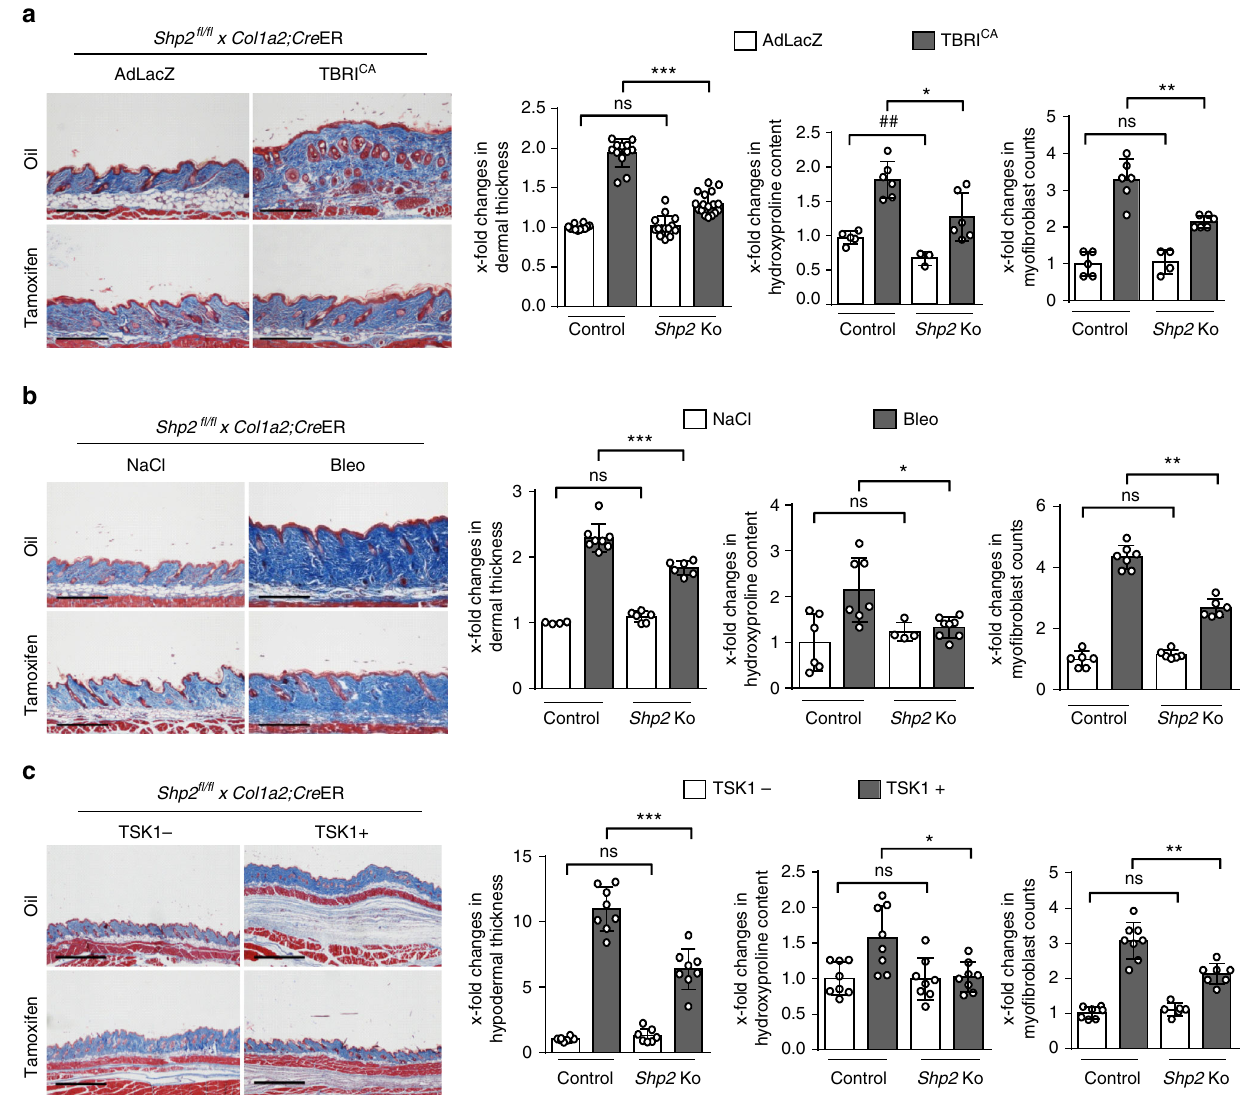
Fig. 4 Fibroblast-speci fi c knockout of Shp2 protects from experimental fi brosis. a TBRI CA -induced fi brosis (6.67 × 10 7 IFUs every 2 weeks). Representative images of Masson trichrome-stained skin shown at 100-fold magni fi cation. Dermal thickness, hydroxyproline content and myo fi broblast counts. All groups consisted of ≥ 9 mice each. b Bleomycin-induced skin (50 µ g every other day) fi brosis. Representative images of Masson trichrome-stained skin shown at 100-fold magni fi cation. Dermal thickness, hydroxyproline content and myo fi broblast counts. All groups consisted of ≥ 8 mice each. c TSK1 model (2 mg tamoxifen over 5 days). Representative images of Masson trichrome-stained skin shown at 40-fold magni fi cation. Hypodermal thickness, hydroxyproline content and myo fi broblast counts. All groups consisted of ≥ 8 mice each. Horizontal scale bar in all images, 500 μ m. All data are presented as median ± s.e. m. The p values are expressed as follows: 0.05 > p > 0.01*; 0.01 > p > 0.001** or ## ; p < 0.001***; ns: not signi fi cant. AdLacZ: adenovirus